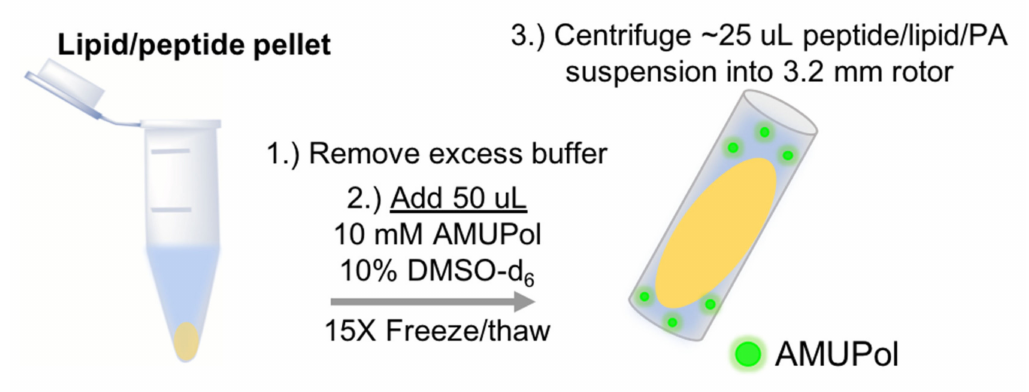
Figure 3. Cartoon schematic of proteoliposome sample preparation for MAS-DNP. The lipid / peptide multilamellar lipid vesicle (MLVs) are produced following traditional membrane peptide or protein sample preparations for ssNMR. Here, the lipid pellet is first hydrated in excess bu ff er and subjected to 15X freeze / thaw cycles to form homogenous MLVs and pelleted by ultracentrifugation. Following this, steps 1–3 illustrate addition of polarizing agents (PA), and additional freeze / thaw cycles to distribute the PA and glassing agent prior to sample transfer into the NMR